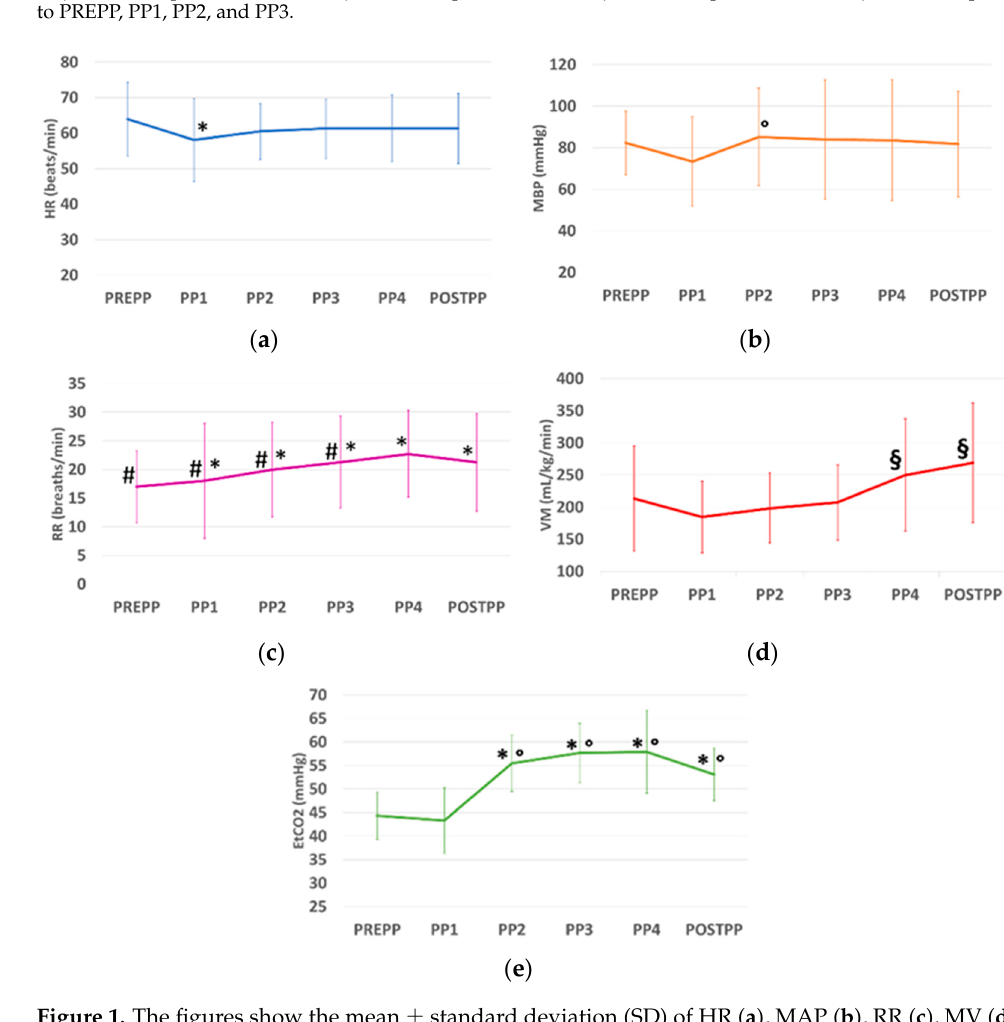
Figure 2. One of the baboons involved in the study after the insertion of the LMA device. The main- stream capnograph is connected to the LMA using an L connector. The hematological values are within the reference range reported for the species, un- less the BUN, which is slightly higher. Although the data show the situation at a single time point, they are useful for verifying the health status of the animals, as well as the hepatic and renal functions, and the CBC. Although laparoscopy is reported in different species of NHPs [2,24], few data exist regarding the effect that pneumoperitoneum has on the physiological variables of the